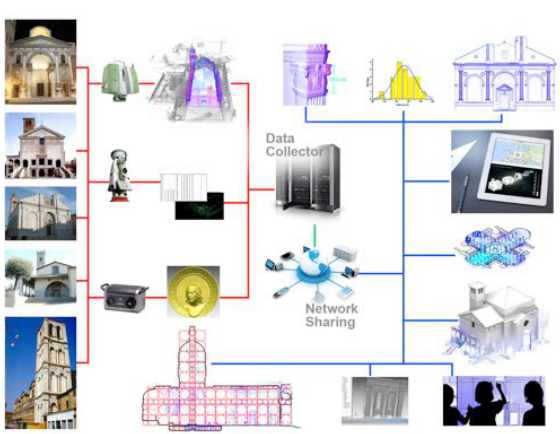
Figure 1: Diagram of the Alberti Project by the data collection in 3D databases and their exploitation for several